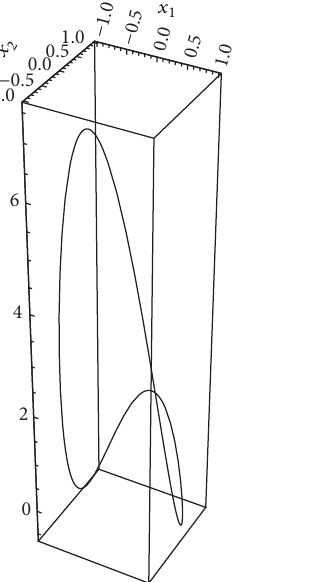
Figure 2: The Lie-Trotter integrator of the system (1), projection on